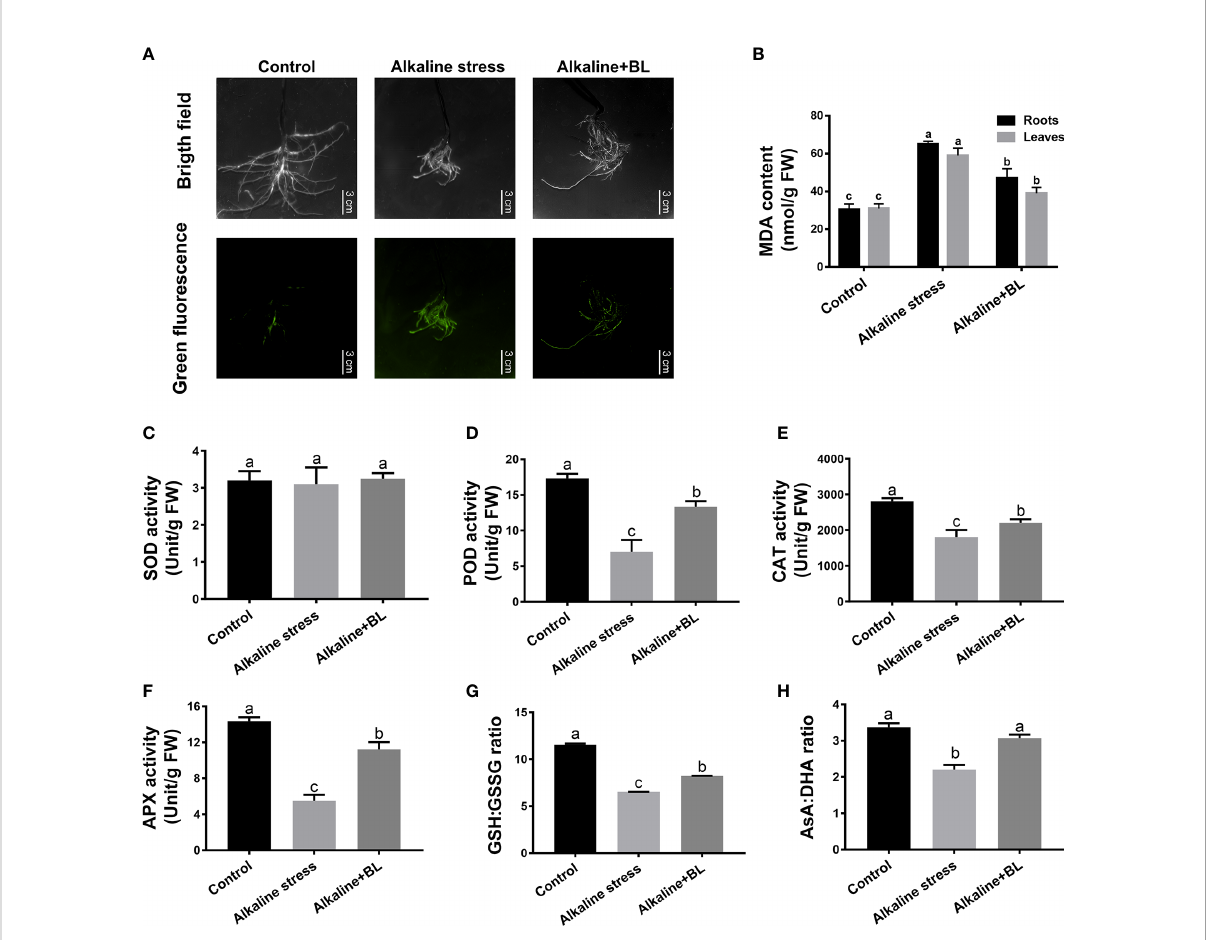
FIGURE 5 Effects of exogenous BL on the oxidative damage, antioxidant enzyme activities and antioxidants contents of M. hupehensis seedlings roots under alkaline stress. (A) Effects of alkaline stress and exogenous BL on the ROS level in roots. The scale bar represents 3.0 cm. Effects of exogenous BL treatment on MDA content (B) , SOD activity (C) , POD activity (D) , CAT activity (E) , APX activity (F) , GSH : GSSG ratio (G) and AsA : DHA ratio (H) under alkaline stress. The data represent the mean ± SD of three biological replicates. Different lowercase letters indicate signi fi cant differences according to Fisher ’ s least signi fi cant difference ( P <